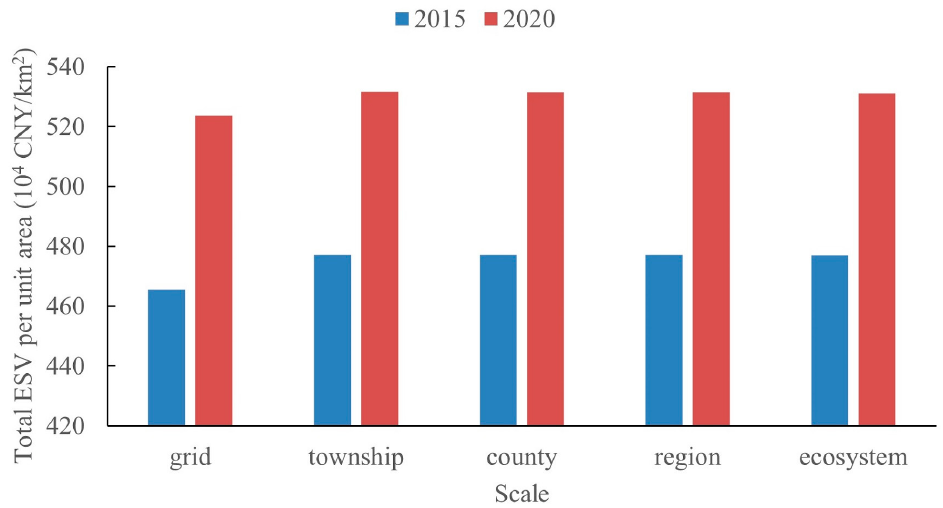
Figure 10. The total ESV per unit area of study at different scales in 2015 and 2020.